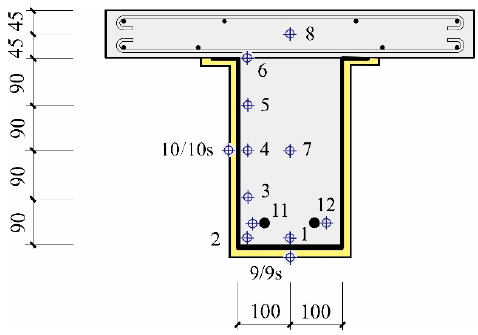
Figure 8. Locations of thermocouples (unit: mm).